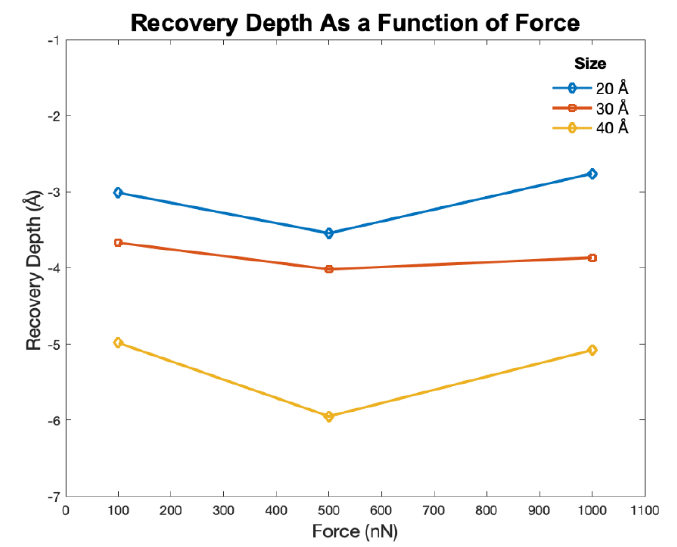
Figure 7. Recovery depth as function of size and force.